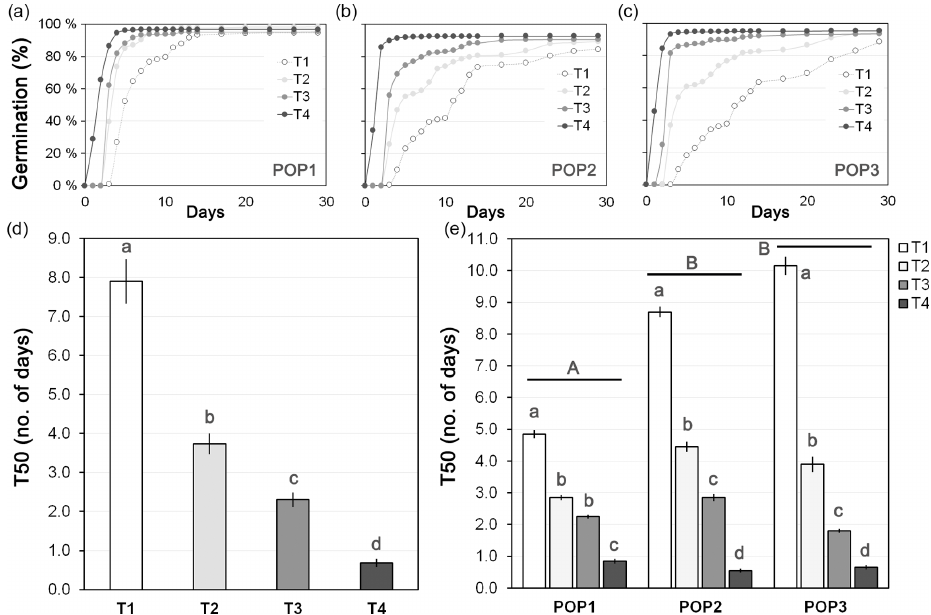
Figure 2. Seed germination of J. maritima diploid populations under different germination conditions. Seed germination (in %) over 1 month after different cold treatments is provided for: (a) population 1 (POP1), (b) population 2 (POP2) and (c) population 3 (POP3). The time needed to reach 50% of total germination rate (T50; mean ± SE; in number of days) is given for (d) each treatment and (e) each treatment within each studied population. Treatment before transfer to the growth chamber: T1, without cold treatment; T2, 3 days at 4 ◦ C; T3, 1 week at 4 ◦ C; and T4, 2 weeks at 4 ◦ C. Different lower-case letters denote significant differences among treatments, including the total comparison (in d ) and among treatments within populations (in e ) at P < 0 . 05; different upper-case letters denote significant differences among populations at P < 0 .